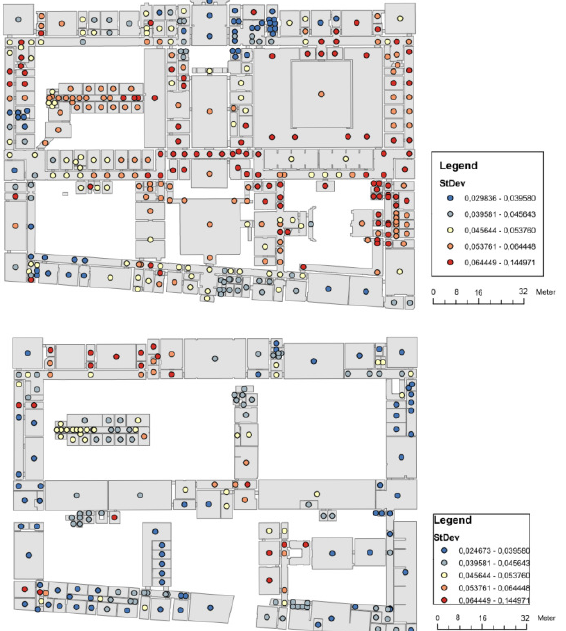
Figure 4: Spatial distribution of the standard deviation of normalized least risk path lengths (floor 0 (top) and 1 (below))